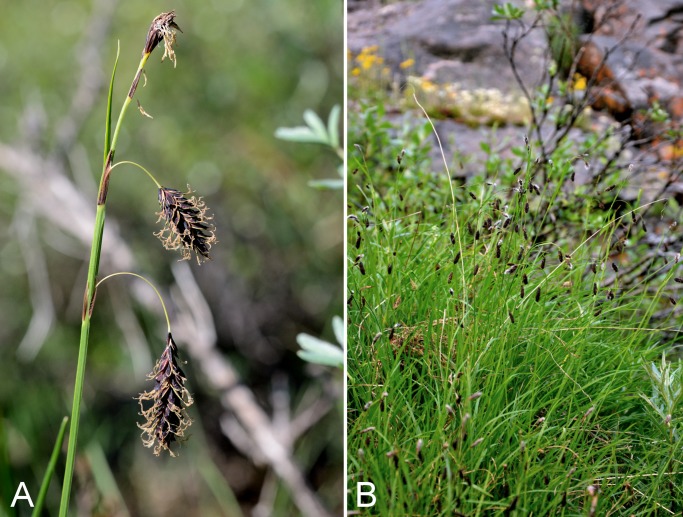
Carex podocarpa.(A) Inflorescence, Saarela et al. 3184. (B) Habit, Saarela et al. 4359. Photographs by R. D. Bull (A) and P. C. Sokoloff (B).